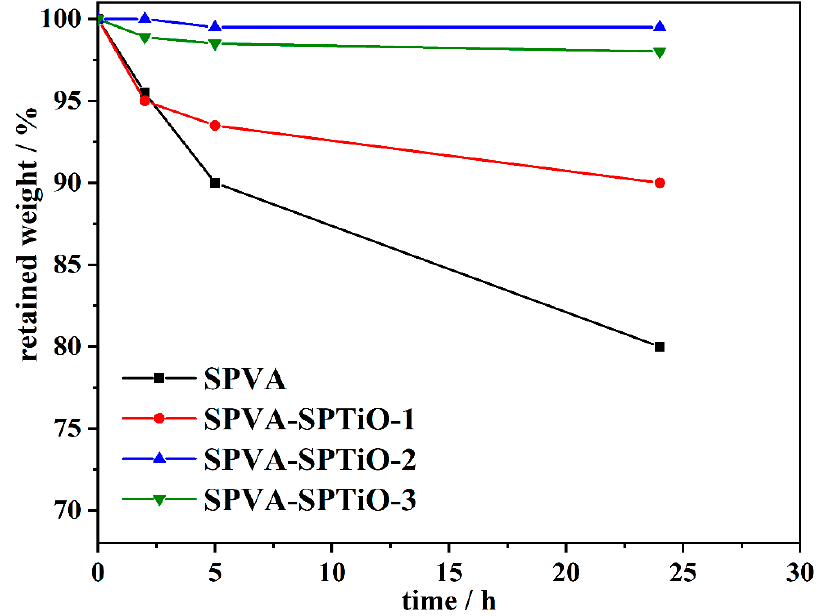
Figure 9. Oxidative stability plots for the prepared membranes. Table 3. Ion exchange capacity (IEC), oxidative stability, borohydride permeability and ionic conductivity of the fabricated membranes and Nafion ® 117